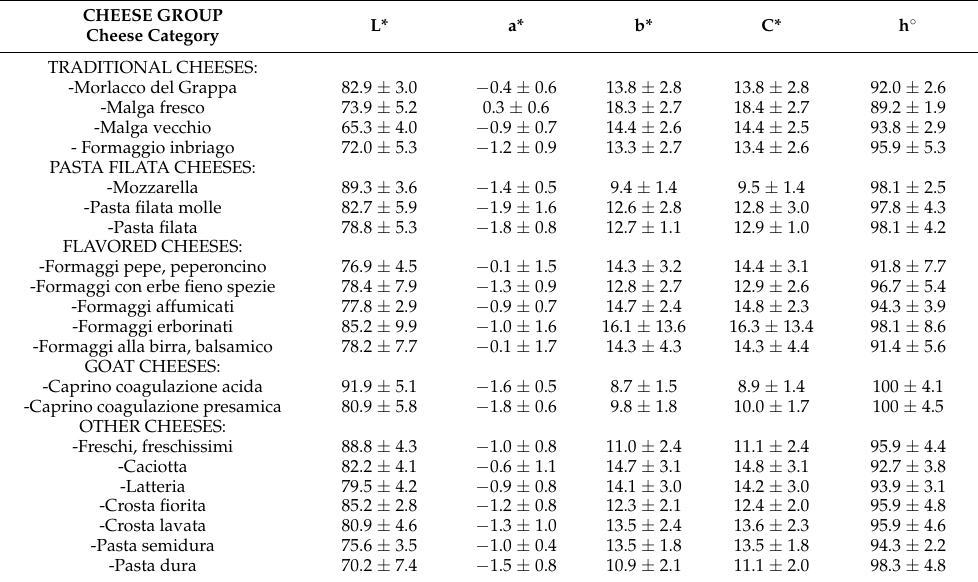
Table 8. Color traits 1 of the paste of the non-PDO cheeses (averages and standard deviations by cheese